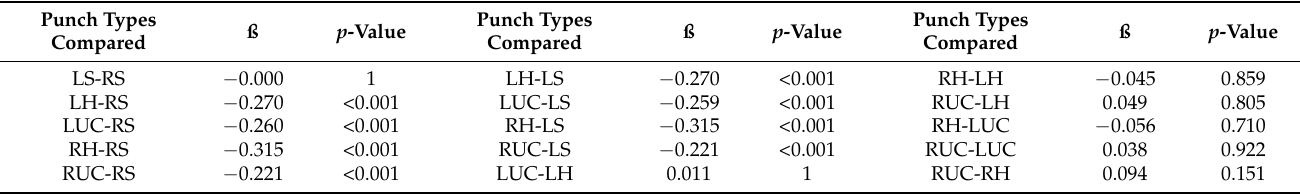
Table 5. Pairwise comparison of the effect of the punch type.